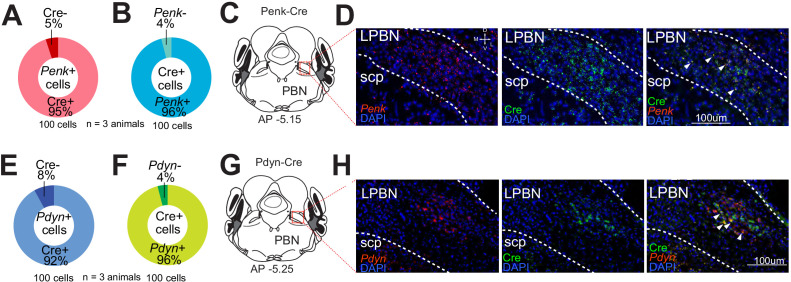
Validation of Penk-Cre and Pdyn-Cre lines in the parabrachial nucleus (PBN).FISH was performed on brain sections from Pdyn-Cre or Penk-Cre mice using probes for prodynorphin or proenkephalin in combination with a probe for Cre transcripts. (A and B) The co-expression of Cre with proenkephalin was quantified by counting 100 cells from three animals positive for labeling of either (A) proenkephalin or (B) Cre and then counting the number of those cells that were also positive for the other probe. (C) Diagram of the anatomic localization of the PBN sections shown in (D) with labeling of proenkephalin (red), Cre (green) and DAPI (blue). Arrowheads highlight examples of cells labeled by probes for both transcripts. (E and F) The co-expression of Cre with prodynorphin was quantified by counting 100 cells from three animals positive for labeling of either (E) prodynorphin or (F) Cre and then counting the number of those cells that were also positive for the other probe. (G) Diagram of the anatomic localization of the PBN sections shown in (H) with labeling for prodynorphin (red), Cre (green) and DAPI (blue). Arrowheads highlight examples of cells labeled by probes for both transcripts.